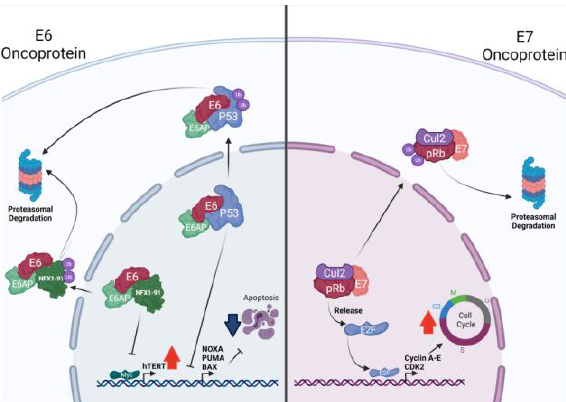
Figure 2. HR-HPV E6 oncoprotein induces p53 degradation, thus impairing the ability of the cell to promote apoptosis. HR-HPV E7 oncoprotein induces the Rb degradation, promoting S phase entry. The E6 protein blocks the binding of the transcription factor p53 to the promoters of pro-apoptotic genes through its binding with the ubiquitin ligase E6-AP, thus inducing its proteasomal degrada- tion. Additionally, the E6 protein promotes transcriptional activation of the promoter of the catalytic subunit of telomerase enzyme (hTERT) in a myc-dependent manner. This mechanism is induced by the degradation of NFX1-91 mediated by the binding of E6 to E6-AP. The E7 oncoprotein induces the degradation of the retinoblastoma protein (pRb) by binding to the Cullin 2 protein (Cul2), which is part of the E3 ubiquitin ligase complex. Thus, the release of E2F occurs along with the subsequent binding as a transcription factor to the genes that regulate the cell cycle. 3. HPV Infection and Breast Cancer 3.1. Routes for HPV Infection in Breast The possible route of HPV infection to the breast is yet to be fully known. Lawson et al. found the same HR-HPV genotype in both BC specimens and squamous intraepithelial lesions of the cervix (SILs) counterparts from the same patients [76]. Additionally, the presence of HPV infection was reported in BC samples from women with HPV-associated SILs [77,78]. Taken together, these findings allowed the authors to suggest that HPV could reach the breast tissue through circulation (blood or lymphatic systems) in patients who displayed HPV-positive cervical cancer [79]. Bodaghi S et al. (2005) and others suggested that HPV could be transmitted through the bloodstream because HPV DNA was found in peripheral blood mononuclear cells (PBMC) [80]. However, all these findings failed to demonstrate that infectious HPV was present in the blood or that PBMC cells are suscep- tible to or permissive for HPV infection. The evidence shows that basal cells in a stratified epithelium are susceptible to HPV infection, with only cells from the upper highly differ- entiated epithelium strata, being permissive. Whether HPV virions are transported to the bloodstream from infected sites to reach the breast or any other anatomical region, has not yet been demonstrated and remains a matter of speculation. Therefore, as HPV replication occurs in the stratified epithelium as a mechanism to evade immune recognition, a route through the bloodstream seems difficult to sustain from a virological point of view. It has also been suggested that free HPV DNA in blood could reach the breast, which can incor- porate this viral DNA through transference [78,81]. Interestingly, De Carolis et al. reported that HPV DNA is found in the serum-derived extracellular vesicles (EV) and may be trans- ferred to TNBC. The authors suggested the possibility that HPV DNA from EV can confer an increased aggressive feature to the BC [82,83]. However, further studies are needed to clarify whether HPV DNA is transported from HPV infected sites, through EV, to this anatomical site. Another theory proposes that HPV could reach the breast tissue through nipple or areola microlesions of breast skin that may occur during oral-breast or genital- breast sexual intercourse [79]. Therefore, considering that HPV infection requires direct contact with cutaneous or mucosal epithelium, this transmission route to the breast ap- pears to be the most feasible alternative for HPV entry to breast cells. We cannot deny the